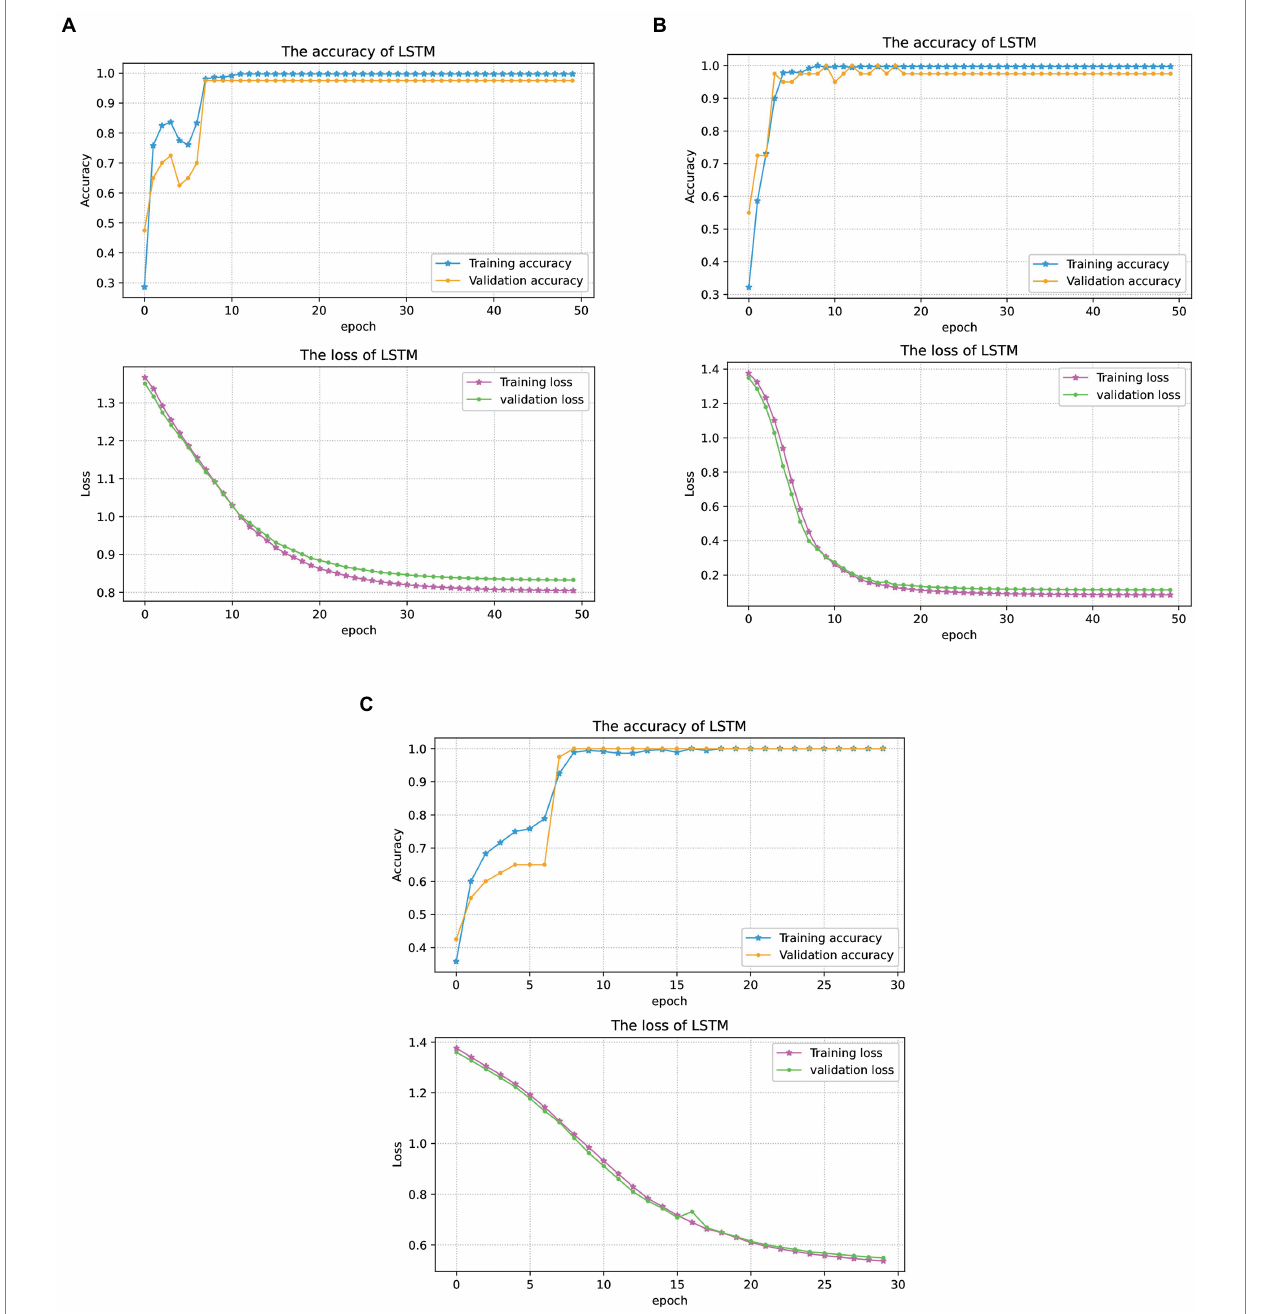
FIGURE 10 The first experiment results under three conditions. (A) CSL gestures classification results under condition 1. (B) CSL gestures classification results under condition 2. (C) CSL gestures classification results under condition 3. In panels (A–C) , the blue curves with star markers denote the recognition accuracy of the training set, and the yellow curves with circle markers denote the recognition accuracy of the testing set. The magenta and green curves are the loss values of the training sets and testing sets,